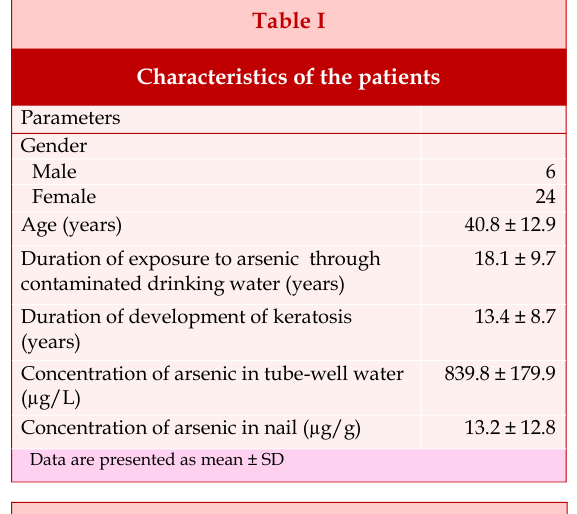
Characteristics of the patients